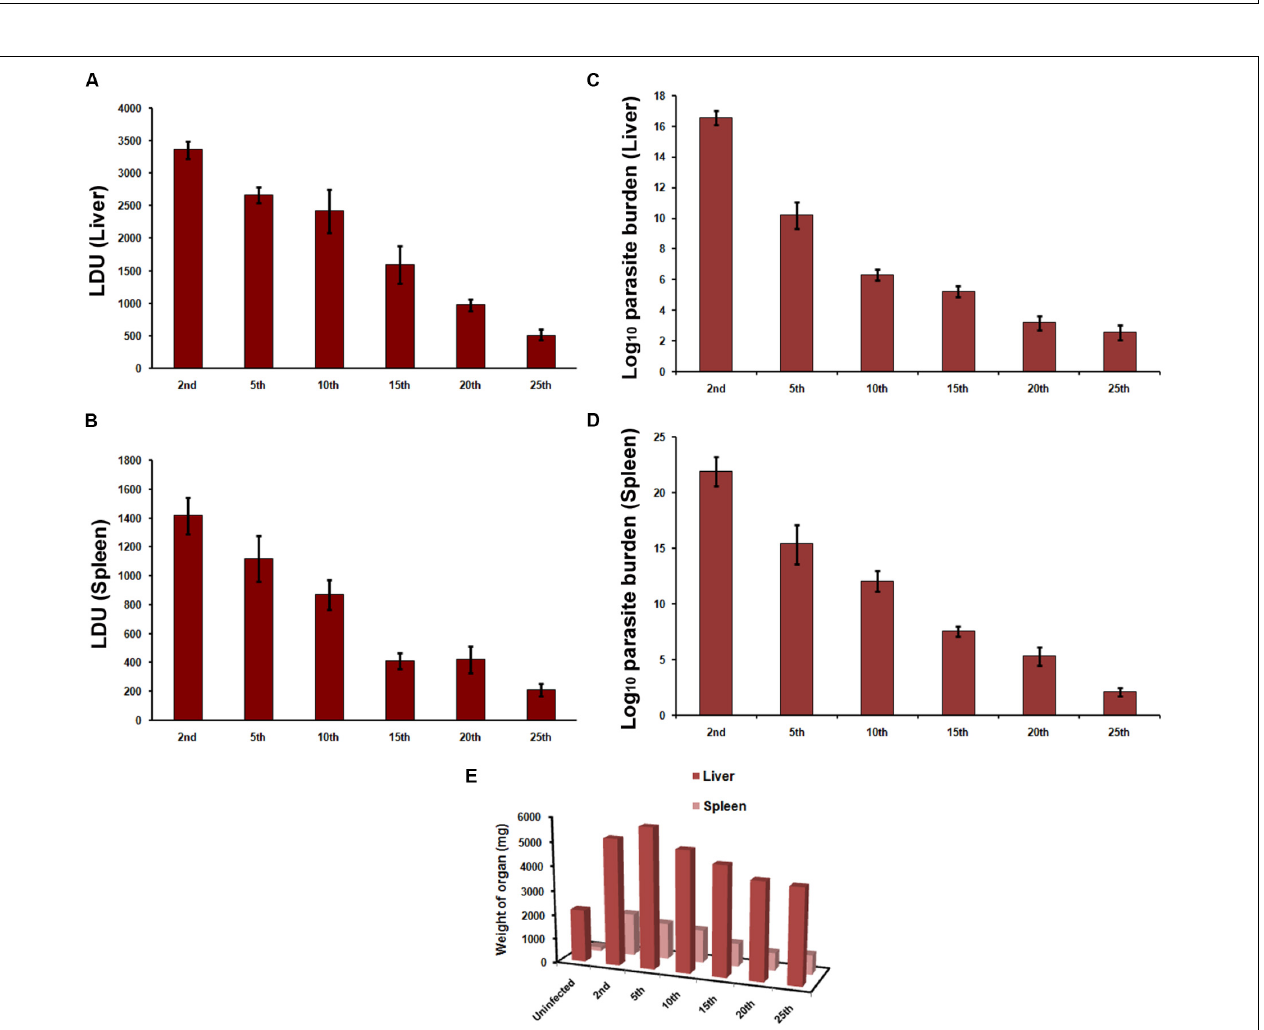
FIGURE 2 | Infection in hamsters. Hamsters were infected by intracardiac injection of 2 × 10 7 L. donovani AG83 promastigotes. Animals were sacrificed at 8 week post-infection and (A,C) liver and (B,D) spleen parasite burden was determined by (A,B) LDU and (C,D) LDA.Data represent mean ± SE of two independent experiments ( n = 4–6). (E) The mean weights of liver and spleen were compared with respective organ weights of uninfected animals.